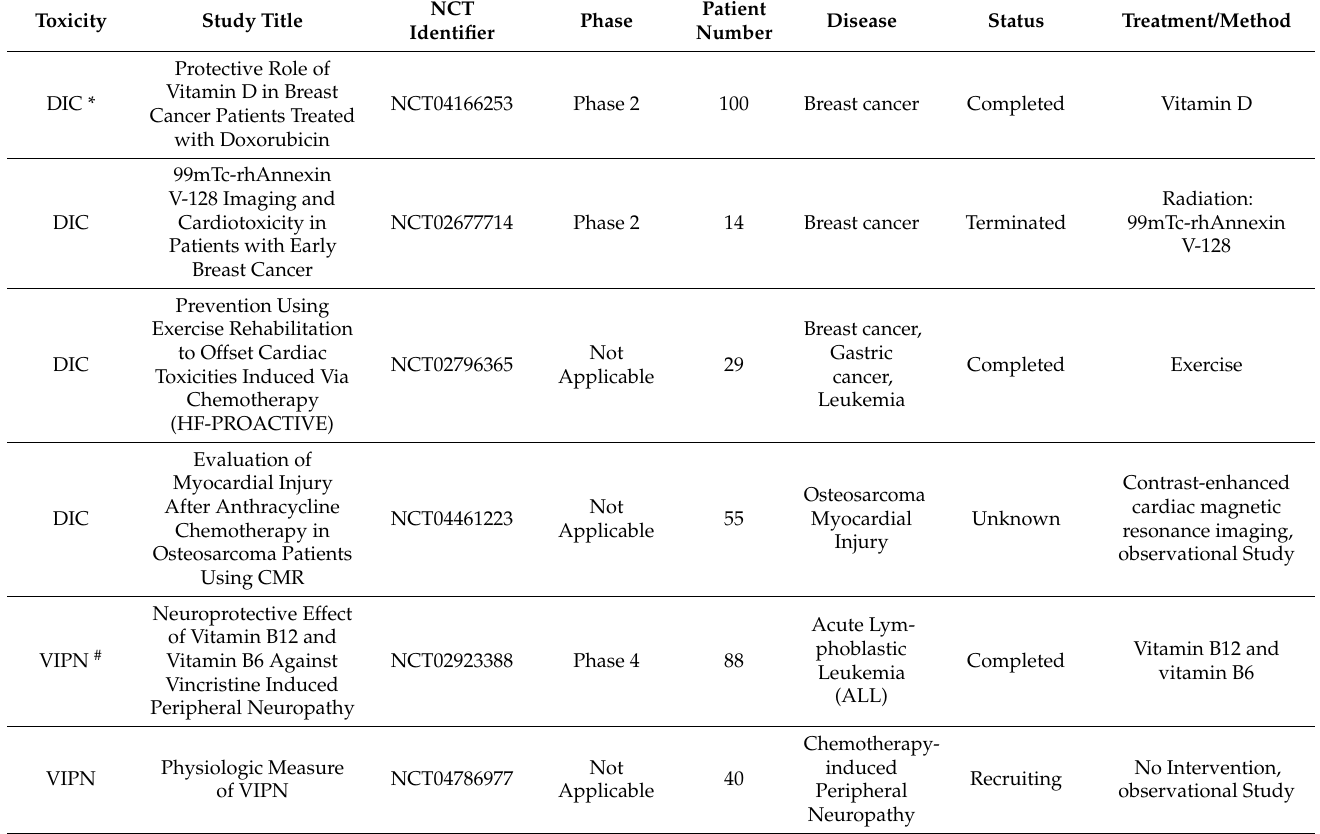
Table 3. Clinical trials of DIC and